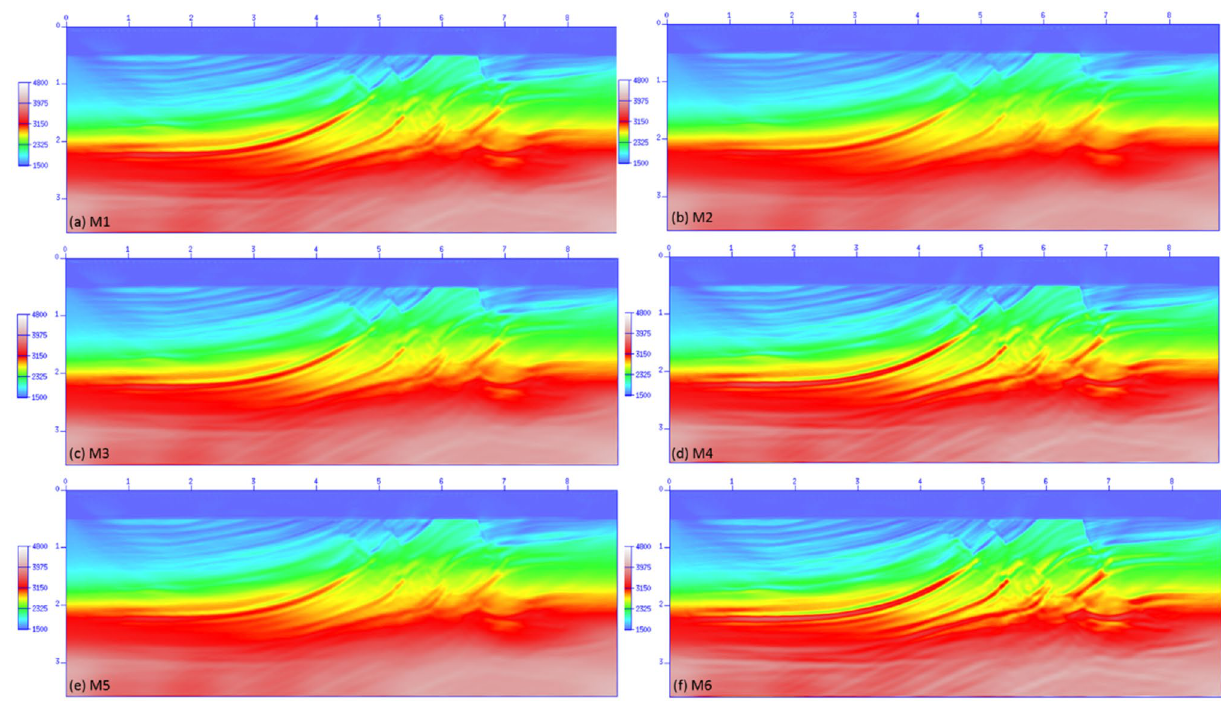
Fig. 4 Cartoon presenting the inverted model after the 100th iteration for different methods